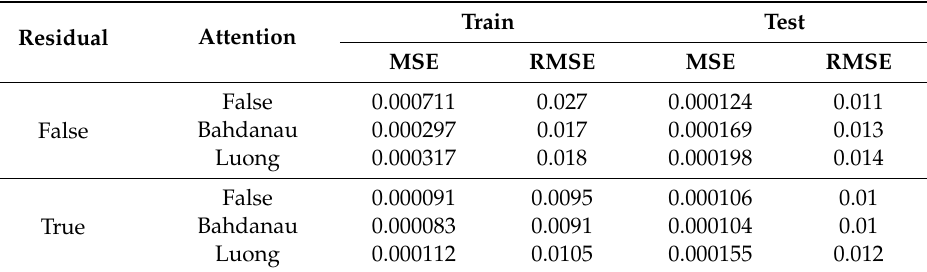
Figure 11. The errors of different mechanisms. Table 1. The algorithm performance comparison between the Residual mechanism and the different Attention mechanisms.